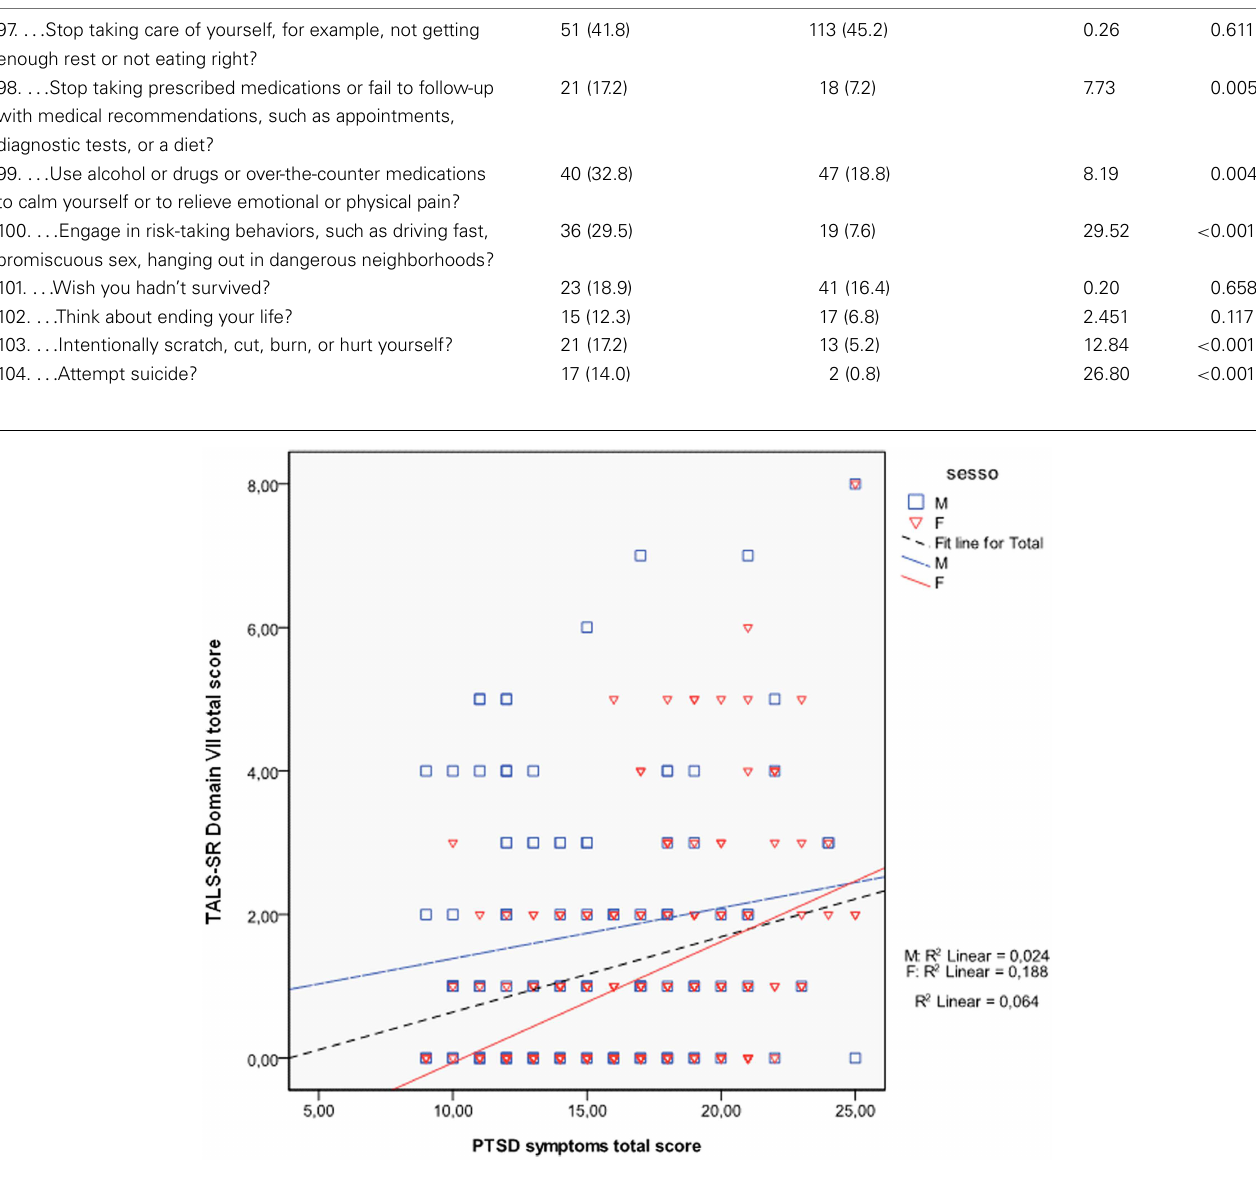
Table 3 | Maladaptive behaviors (TALS-SR DomainVII) prevalence rates in 372 L’Aquila earthquake survivors with PTSD: gender differences. TALS-SR DomainVII (Maladaptive copying)